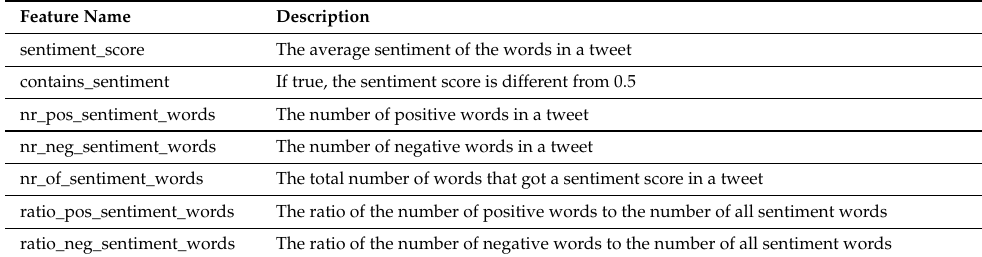
Table A5. Overview of the features that were created according to the polarity of a